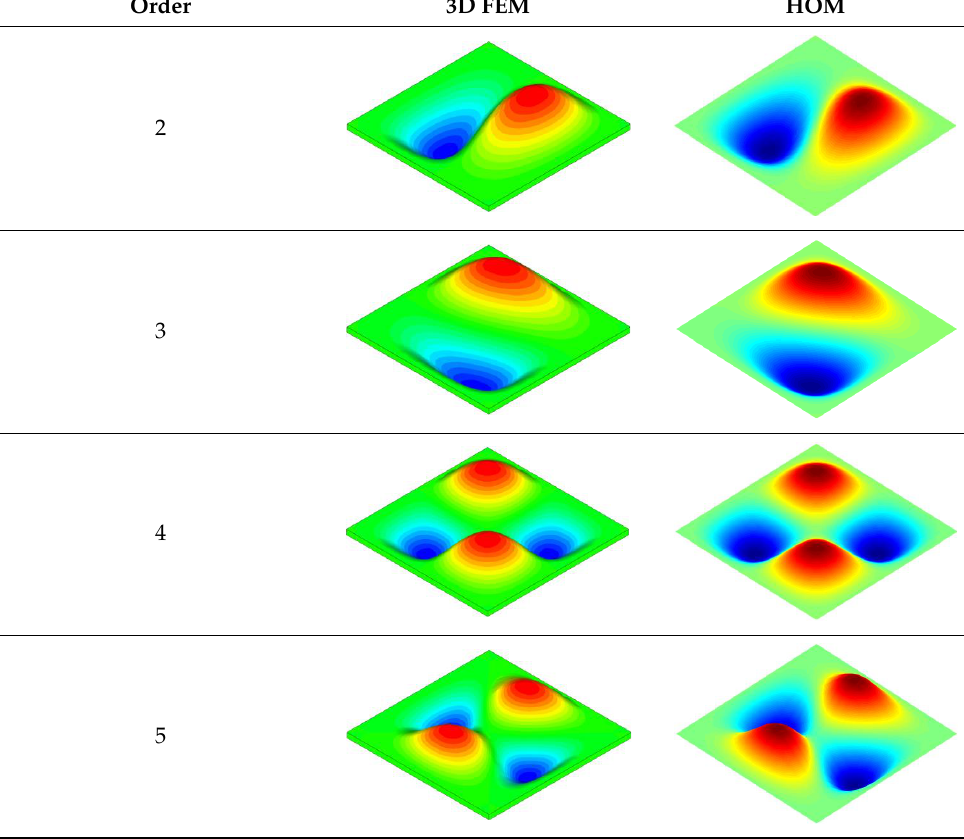
Table 2. First five-order mode shapes of the CCCC single-layer periodic plate.